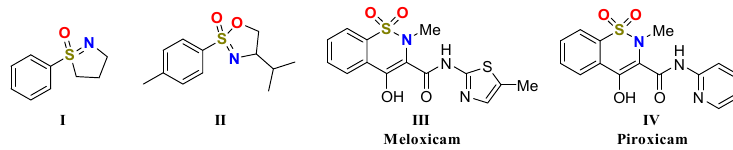
Figure 1. Structures of bioactive cyclic sulfoximines and analogues.